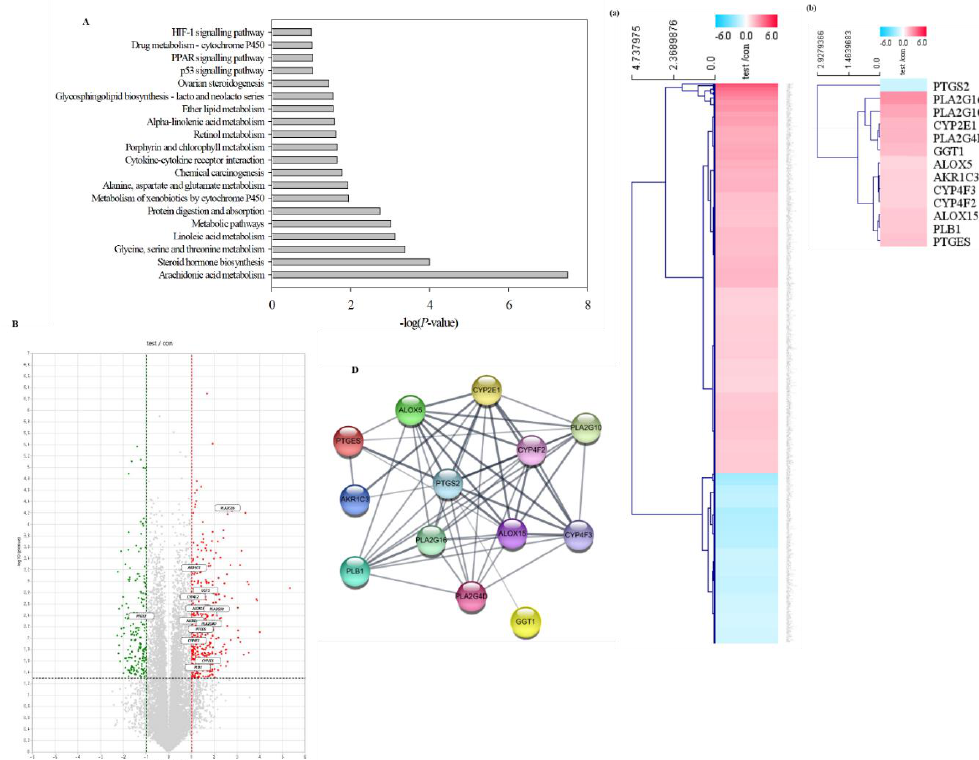
+ . RNA samples were